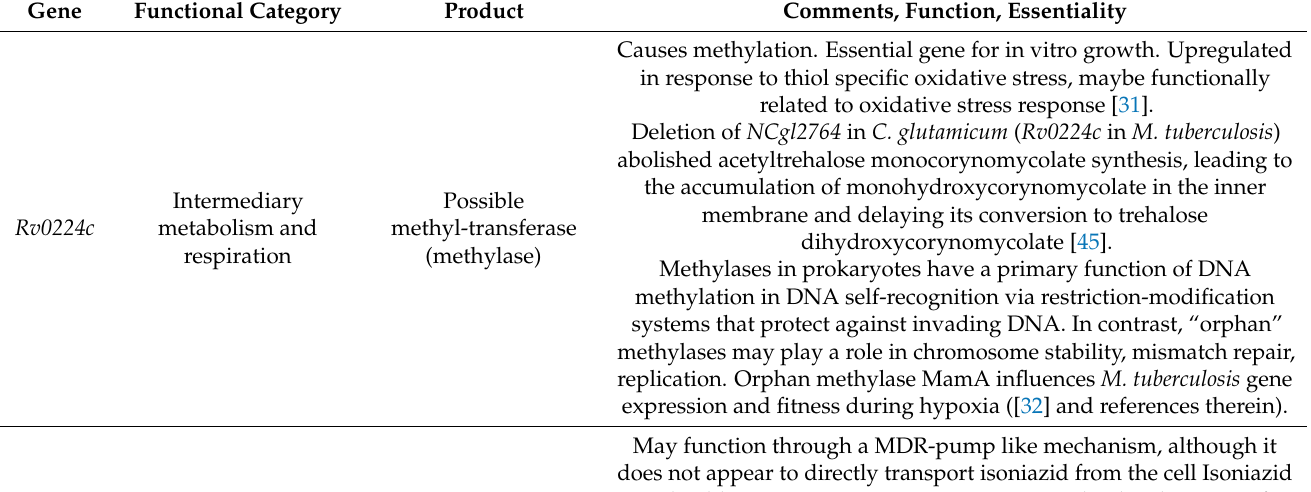
Table 5. Summary of six mutated